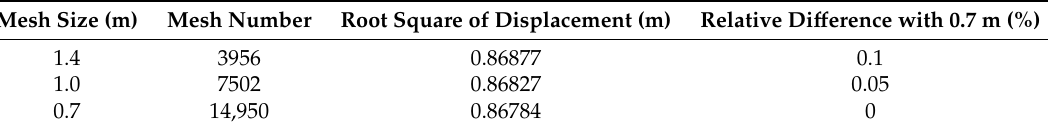
Table 5. The convergence test for TLD mesh selection.